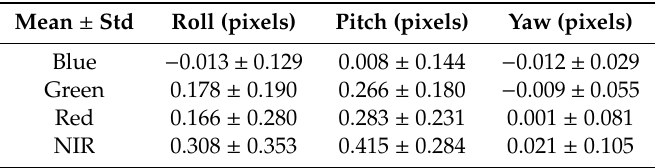
Table 5. Attitude changes in KOMPSAT-2 in row